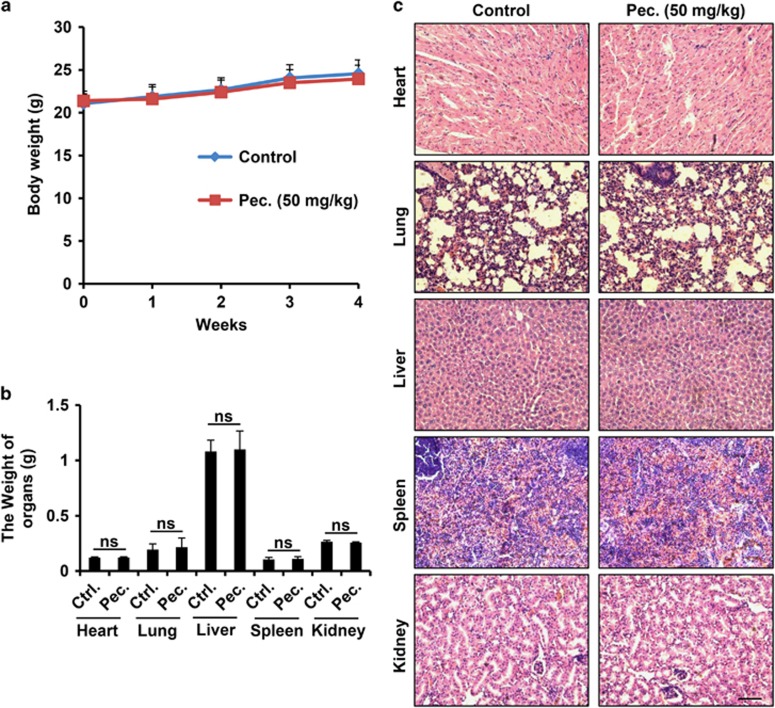
The potential toxicity of pectolinarigenin on mice. (a) Pectolinarigenin was administrated at the dose of 50 mg/kg/2 days for 28 days. Mice body weight was monitored once a week. (b) Major organs weight was evaluated when the experiment terminated. NS, no significance. (c) Major organs from control group and pectolinarigenin-treated group were stained with H&E. Scale bar, 100 μm